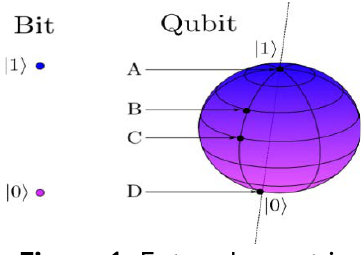
Figure 1. Entanglement is an extraordinary